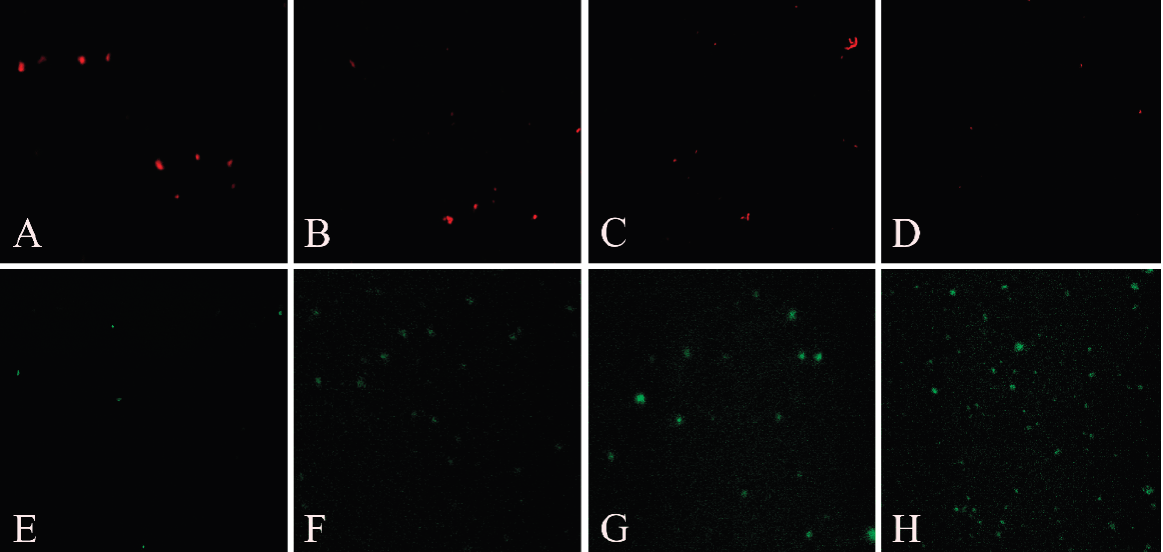
Figure 5. Effects of aqueous extract of EF on mitochondrial transmembrane potential by fluorescence microscope. The picture A – D are red fluorescence of groups of control, 6, 12, 24 g/kg aqueous extract of EF treated rat, successively; the E – H are green fluorescence correspond to the